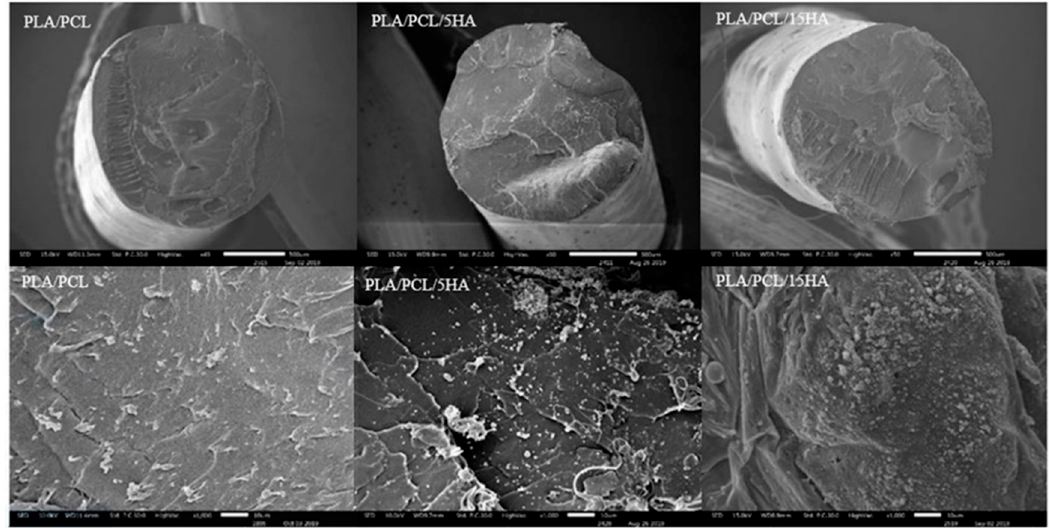
Figure 7. SEM images of the extruded filaments. Magnifications: 50× (Upper), 1000× (Lower). 3.5. Tensile Testing on the Extruded